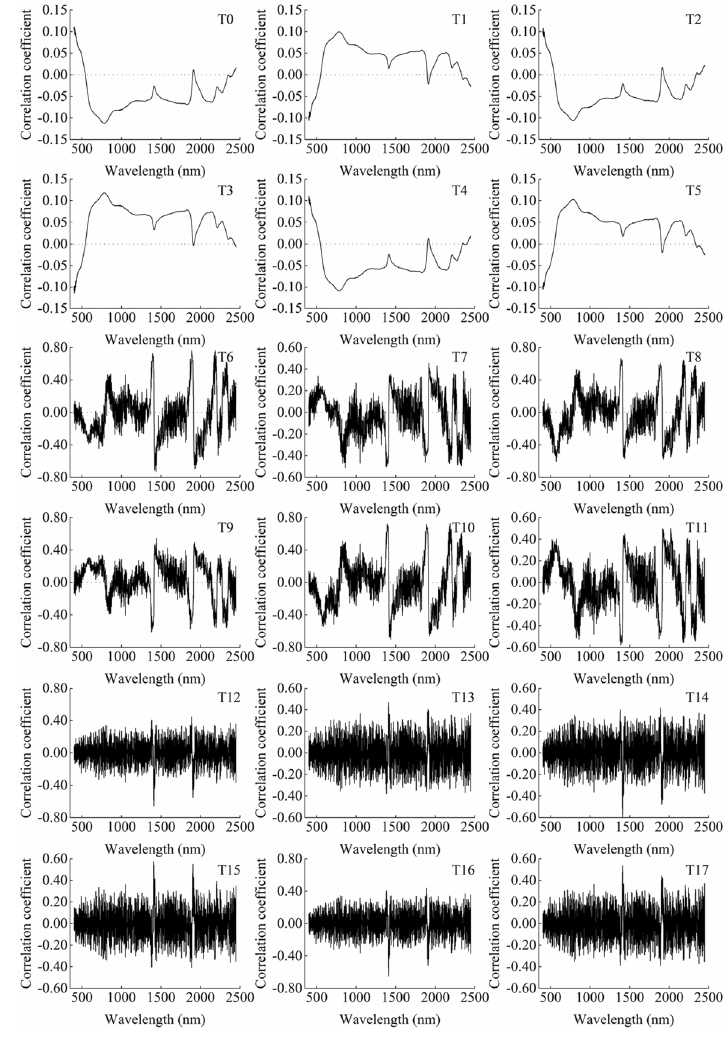
Figure 4. Correlation of different mathematical transformation spectra and SOC content. T0: R; T1: 1/R; T2: Log R; T3: 1/Log R; T4: √ R; T5: 1/ √ R; T6: R’; T7: (1/R)’; T8: (Log R)’; T9: (1/Log R)’; T10: ( √ R)’; T11: (1/ √